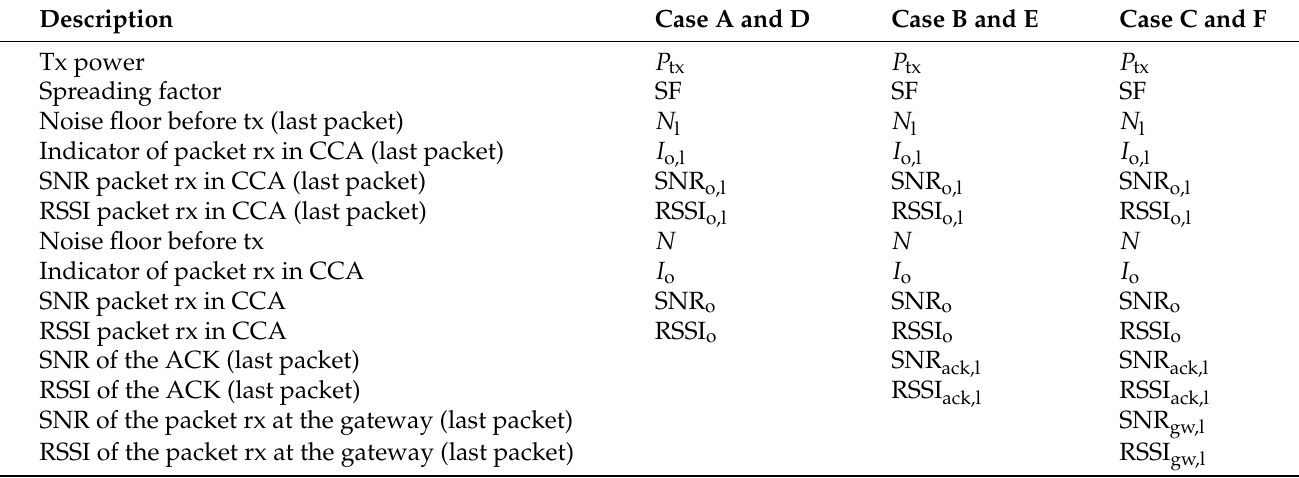
Table 1. Metrics used for each case considered. RSSI: Received Signal Strength; SNR: Signal-to-Noise; CCA: Clear Channel